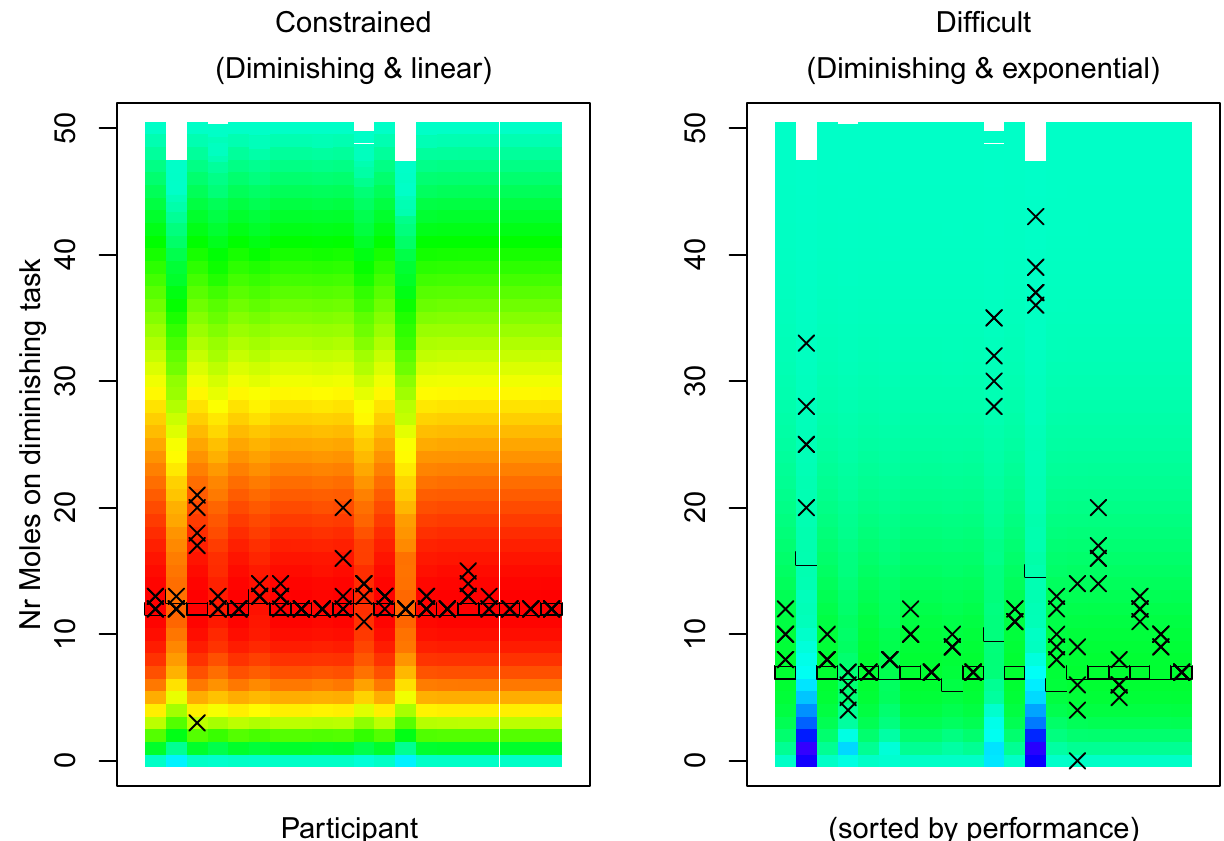
Fig 5. Heatmaps of predicted scores with achieved scores in Experiment 3. The heatmap follows the same format as Fig 4. Despite the even shorter time limit, the majority of participants still performs efficient in the constrained condition.